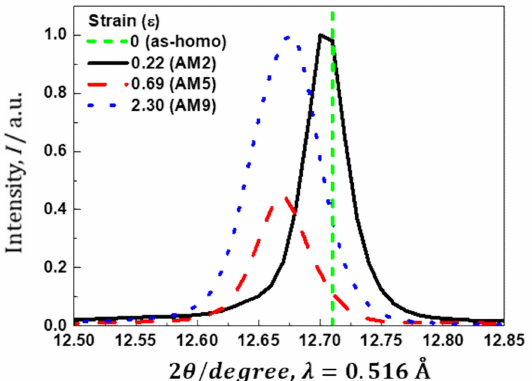
Figure 8. (111) diffracted peak at different amounts of reduction for the DC cast AA3003 aluminum alloy with homogenization.